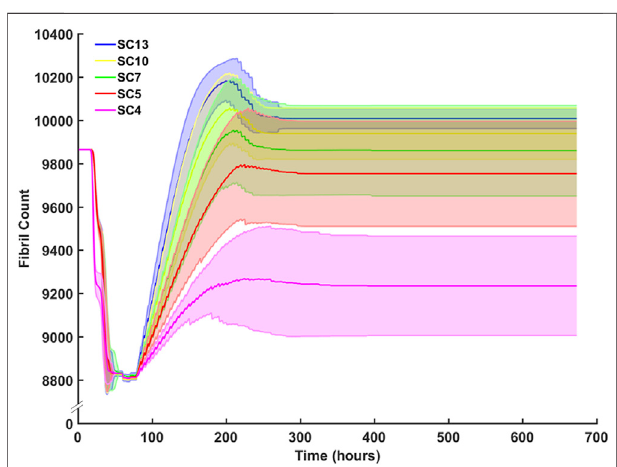
FIGURE 10 | Sensitivity analysis for SC count and the effect on fi bril count (mean ± SD)over simulation timecourse.SCcountwassetto4(CP),5, 7, 10 (TD), and 13. Mean fi bril count increased with increase in seeded SC count.